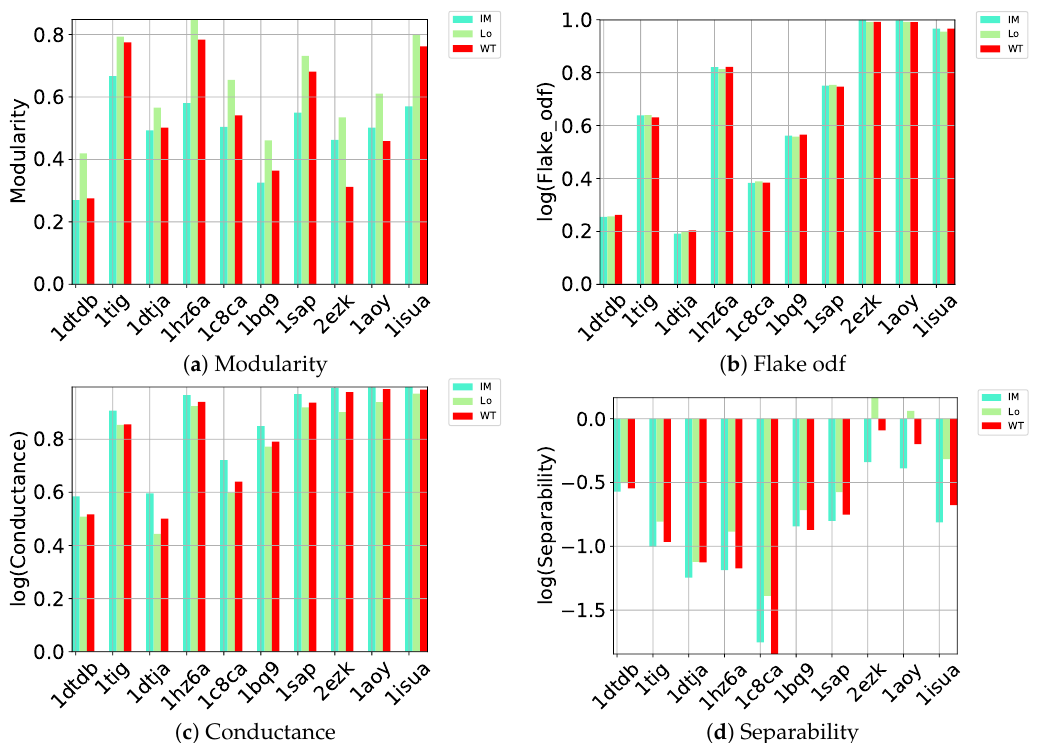
Figure 1. Comparison of community detection methods (encoded by different colors) on directed nngraphs embedding each of the 10 decoy datasets along ( a ) modularity, ( b ) flake odf, ( c ) conductance, and ( d )